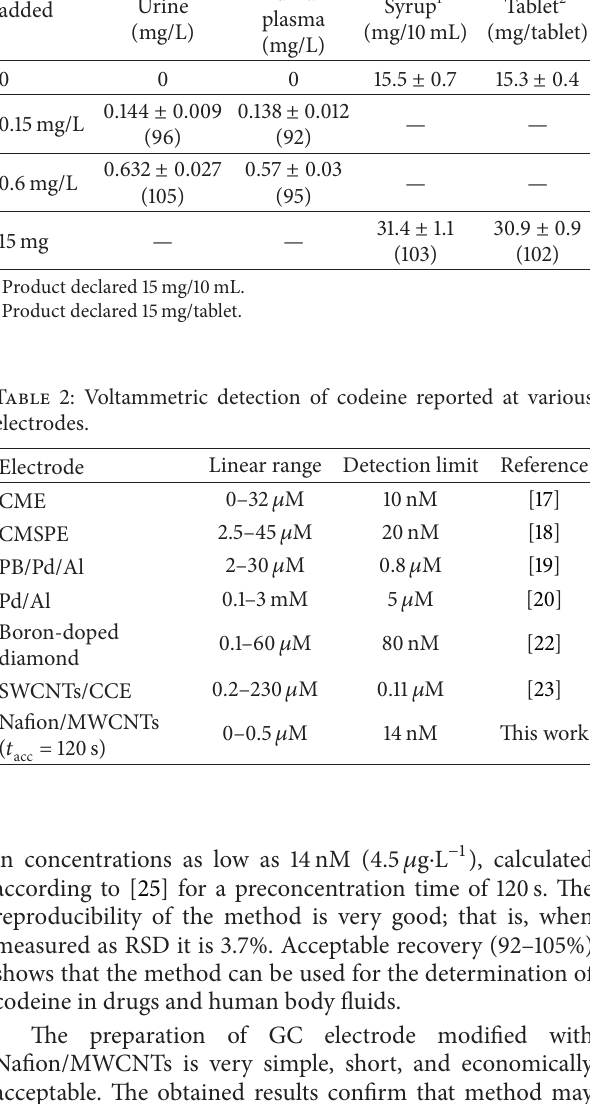
Table 1: Results of codeine determination in various samples. Codeine